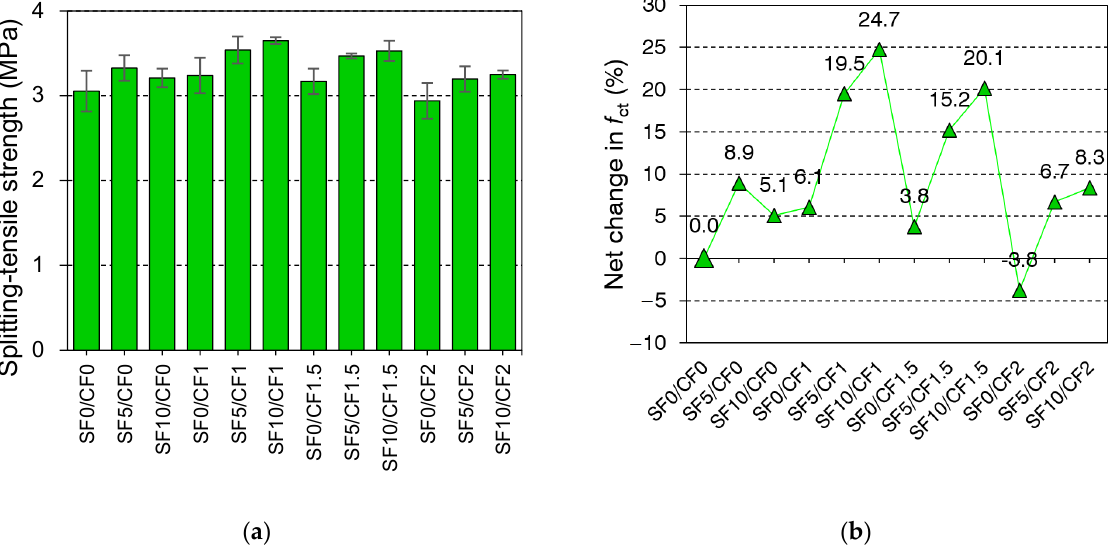
Figure 11. Effect of silica fume and coir incorporation on ( a ) 28-day splitting tensile strength of HSC; ( b ) net change in the splitting tensile strength ( f ct ) of HSC compared to SF0/CF0.